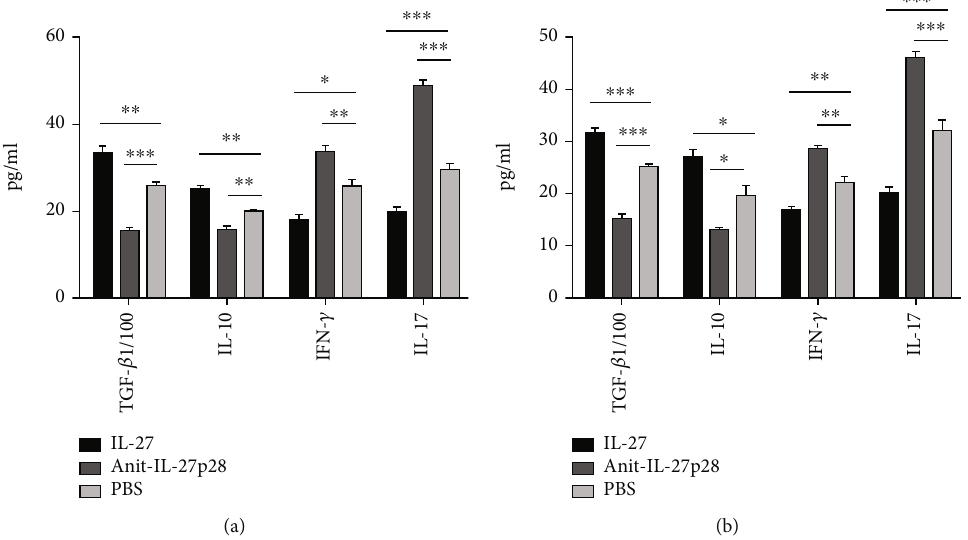
Figure 8: Recombinant IL-27 reduced the levels of IFN- γ and IL-17A in the peripheral blood plasma while increasing the levels of TGF- β and IL-10. Related cytokines level in mice plasma was detected by ELISA. Data from both the initiation (a) and the progression (b) of atherosclerosis were shown in histogram. The meaning of “ TGF-b1/100 ” was the level of TGF- β divided by 100. Because the levels of TGF- β were much higher than the levels of IL-10, IFN- γ , and IL-17A, we used “ TGF-b1/100 ” in this Figure. ∗∗∗ P < 0 : 001 , ∗∗ P < 0 : 01 , ∗ P < 0 : 05